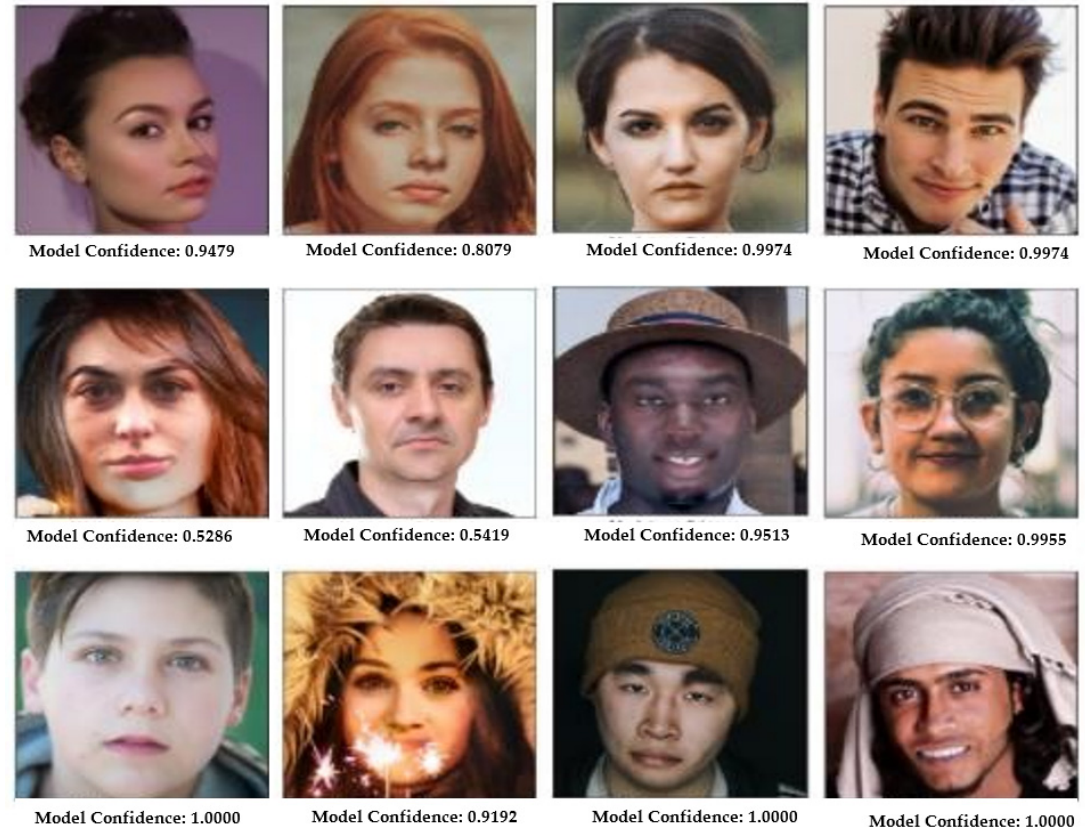
Figure 9. Misclassified DeepFake prediction: showing the model confidence in the prediction.